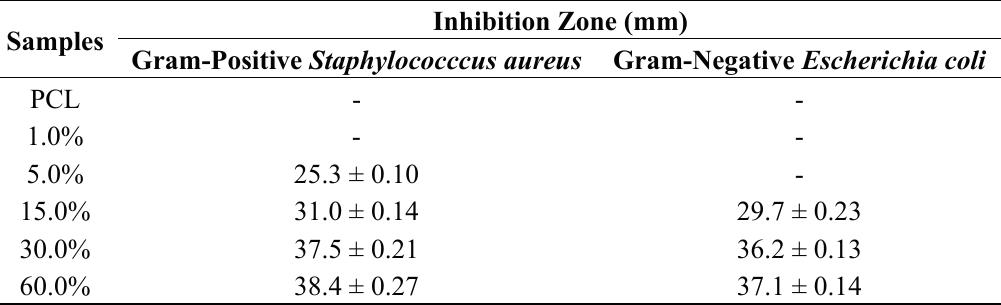
Table 2. Inhibition zone of ORS/Fe 3 O 4 /PCL-NCs in different percentages of ORS/Fe 3 O 4